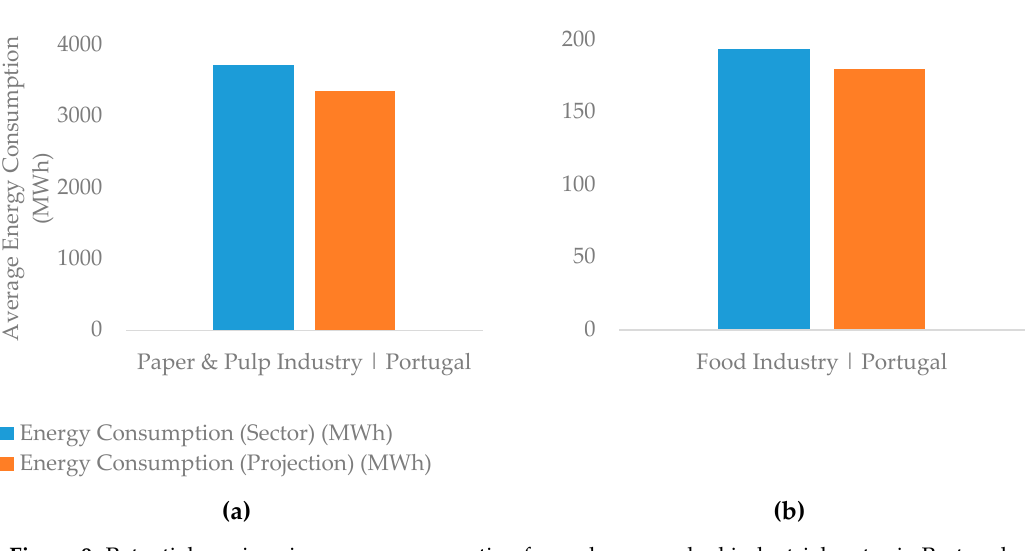
Figure 9. Potentials savings in energy consumption for each approached industrial sector in Portugal. ( a ) paper & pulp industry, ( b ) food industry.